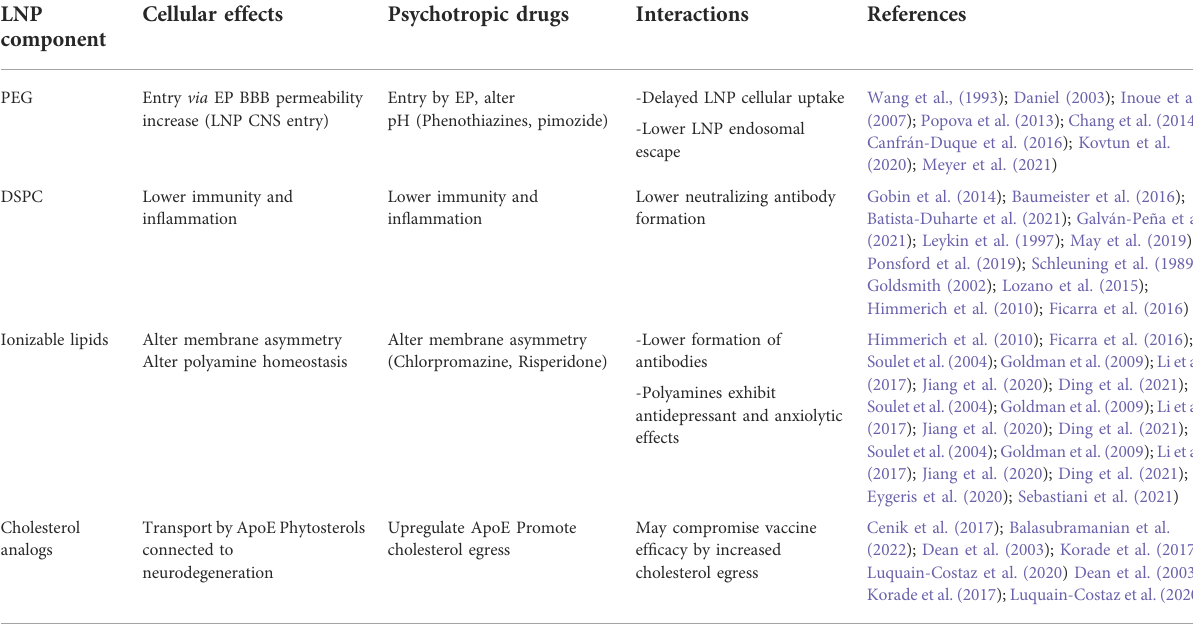
TABLE 1 Psychotropic drugs compound some LNP effects, altering cell entry, endosomal release, and exit of mRNA vaccines and their